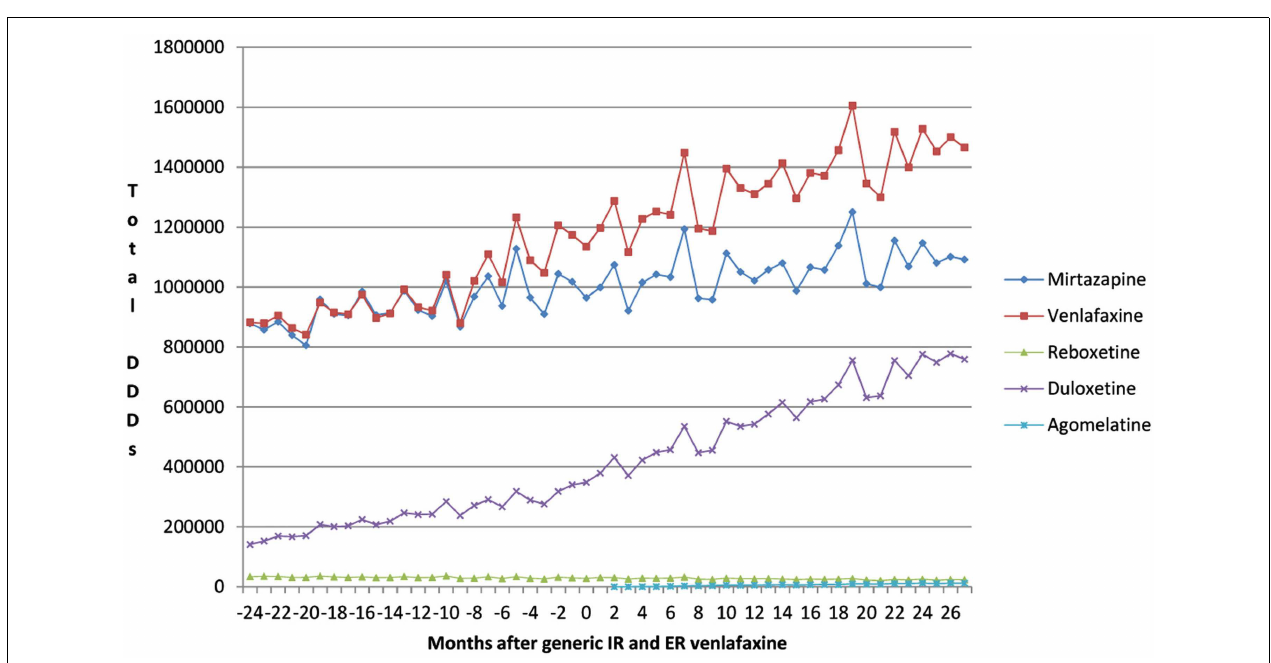
FIGURE 1 | Utilization pattern of newer antidepressants in DDDs before and after generic IR and ER venlafaxine (May 2009).